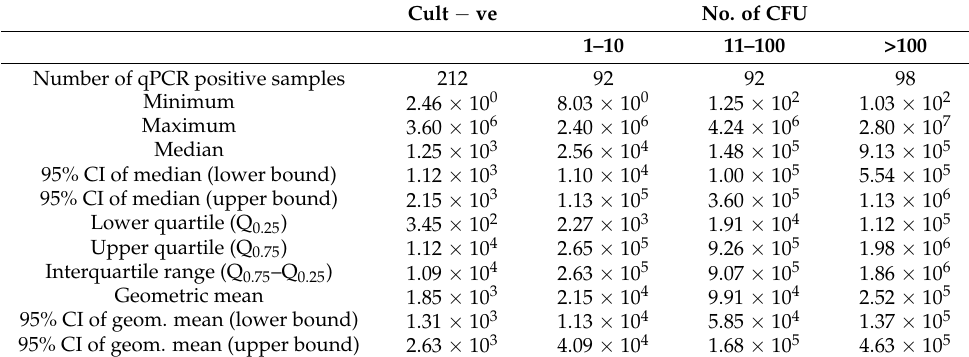
Table interpretation. n = no. of examined samples, CFU = colony-forming units, >100 = too numerous to count, CI = confidence interval.